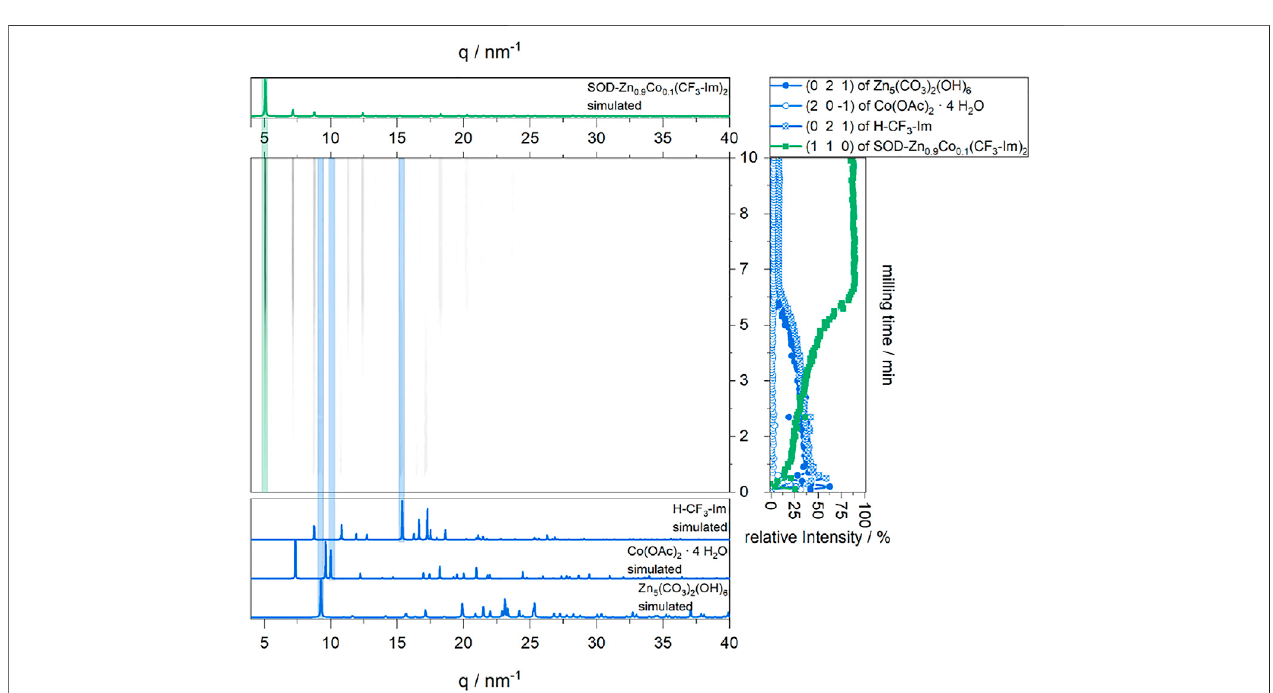
FIGURE 7 | In situ XRD of Zn 5 (CO 3 ) 2 (OH) 6 , Co(OAc) 2 · 4 H 2 O, and H-CF 3 -Im under DMF LAG conditions, yielding (center). For comparison, the simulated XRD patterns of starting materials (blue, bottom) and the product (green, top) are shown. The intensities of chosen re fl ections of the present phases are plotted on the right. XPS studies on pristine and carbonized MOFs.